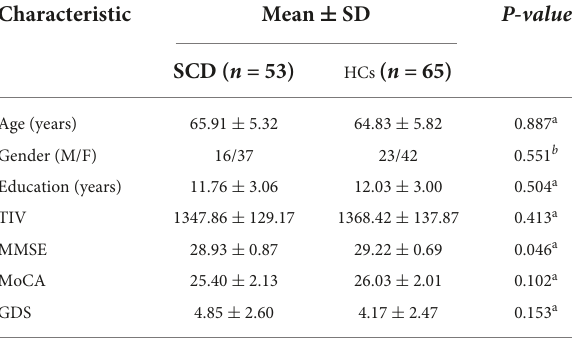
TABLE 1 Demographic and clinical characteristics of subjects.